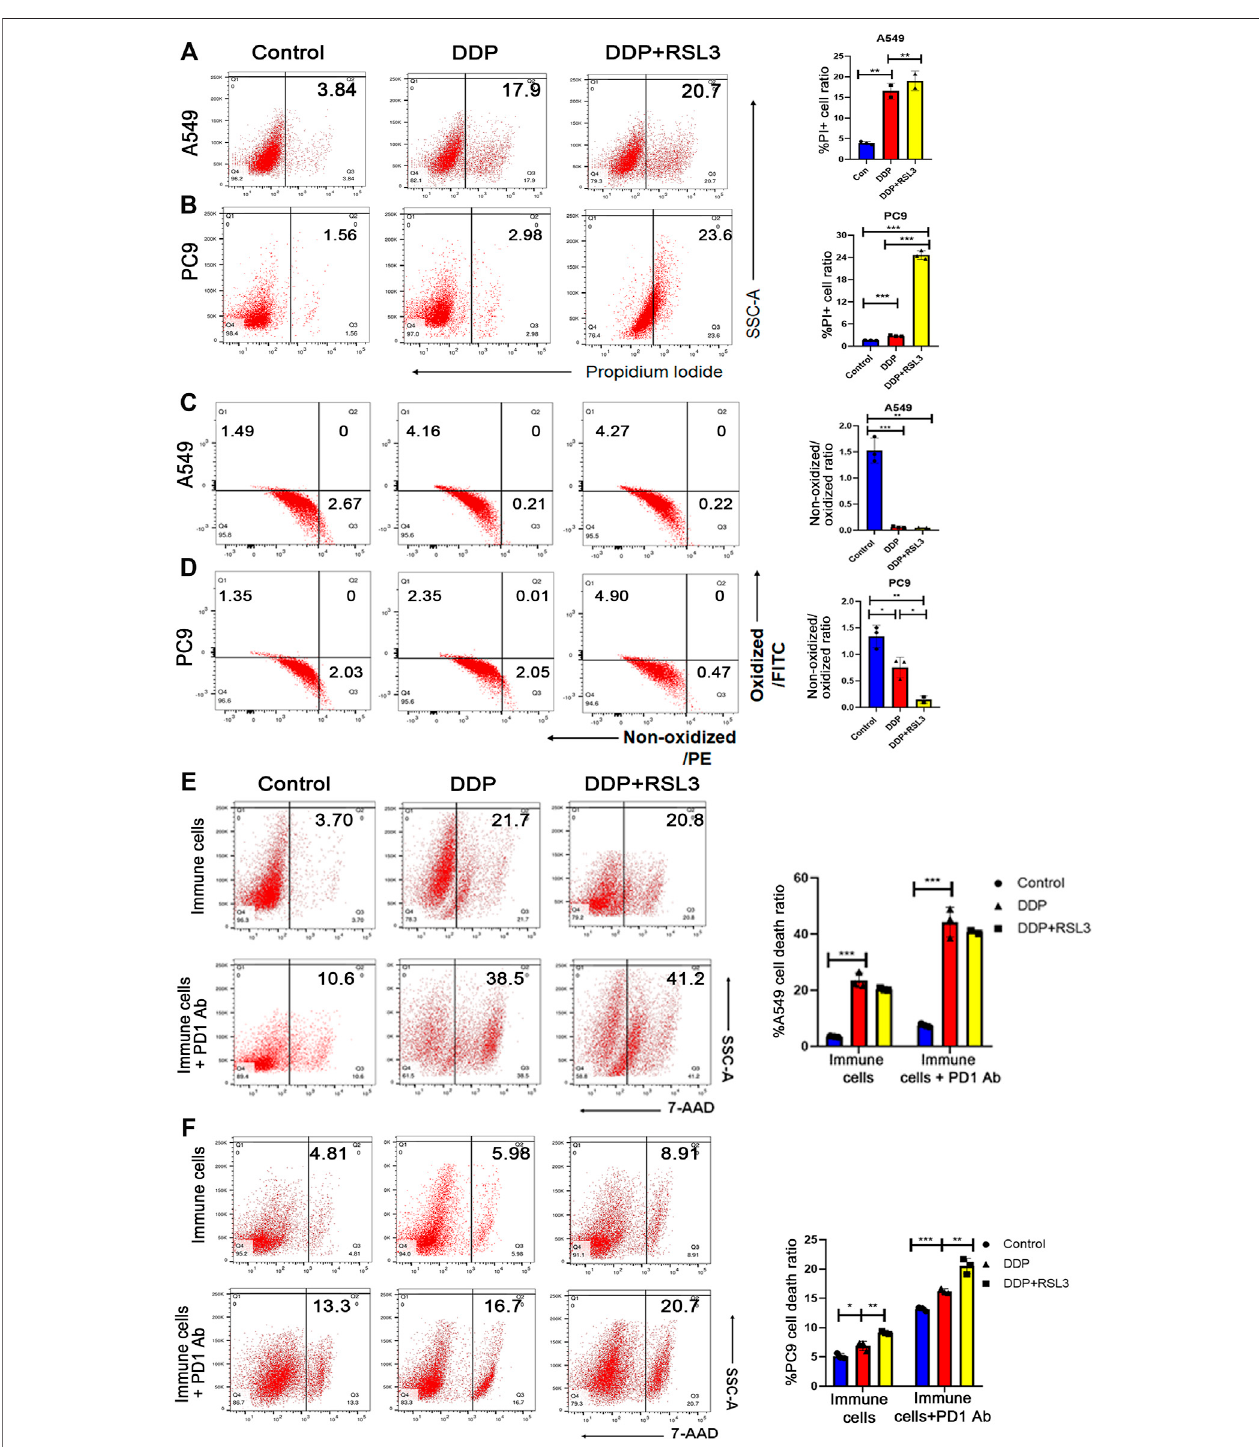
FIGURE 6 | Ferroptosis induced the sensitivity of EGFR-mutant NSCLC to immunotherapy. (A) and (B) PI staining indicates that more A549 cells die after DDP treatment than PC9 cells. However, DDP plus RSL3 signi fi cantly increased cell death ratio in PC9 cells, while RSL3 did not induce a much higher level of cell death in A549cells. (C) and (D) LipidperoxidationassaysindicatedthatA549cellsshowedmorelipidperoxidationafterDDPtreatmentthanPC9cells.DDPplusRSL3resultsin more lipid peroxidation in PC9 cells while RSL3 did not induce much more lipid peroxidation in A549 cells. (E) Representative fl ow cytometry images of A549 cell death ratio in the co-culture system with immune cells. An addition of RSL3 to DDP did not signi fi cantly increase cell death level in the co-culture before and after PD1 administration. (F) Representative fl ow cytometry images of PC9 cell death ratio in the co-culture system with immune cells. An addition of RSL3 to DDP signi fi cantly increasescelldeathlevelintheco-culturebeforeandafter PD1administration. Bargraphsrepresentthemean±SDofindicatedsamples. p p < 0.05, pp p < 0.01, ppp p <